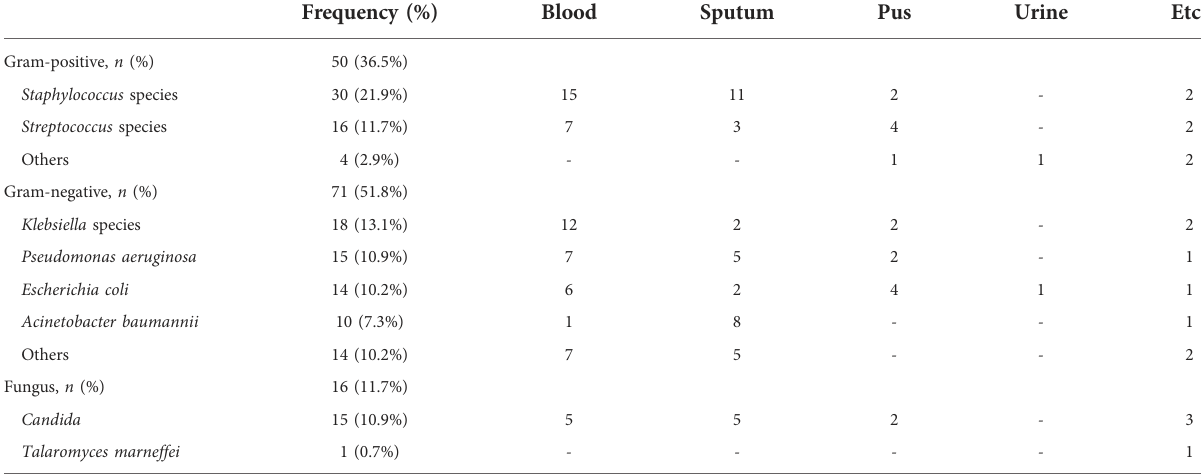
TABLE 5 Frequency of bacteria for the positive